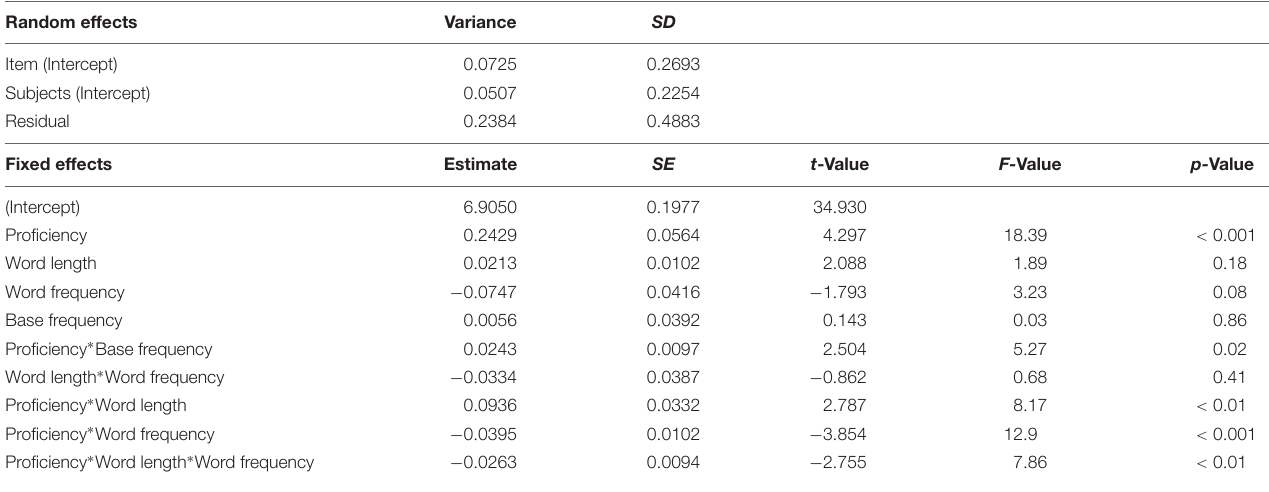
TABLE 5 | Words derived from noun base: mixed-effects on gaze